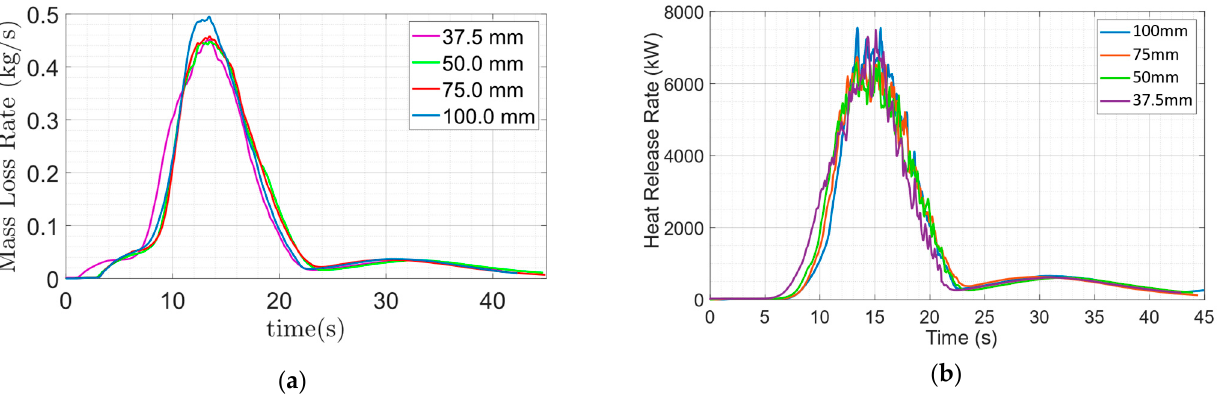
Figure 6. Comparison of peak aligned ( a ) MLR, ( b ) HRR for 2.6 m Douglas fir tree simulations for grid size 100, 75, 50 and 37.5 mm.